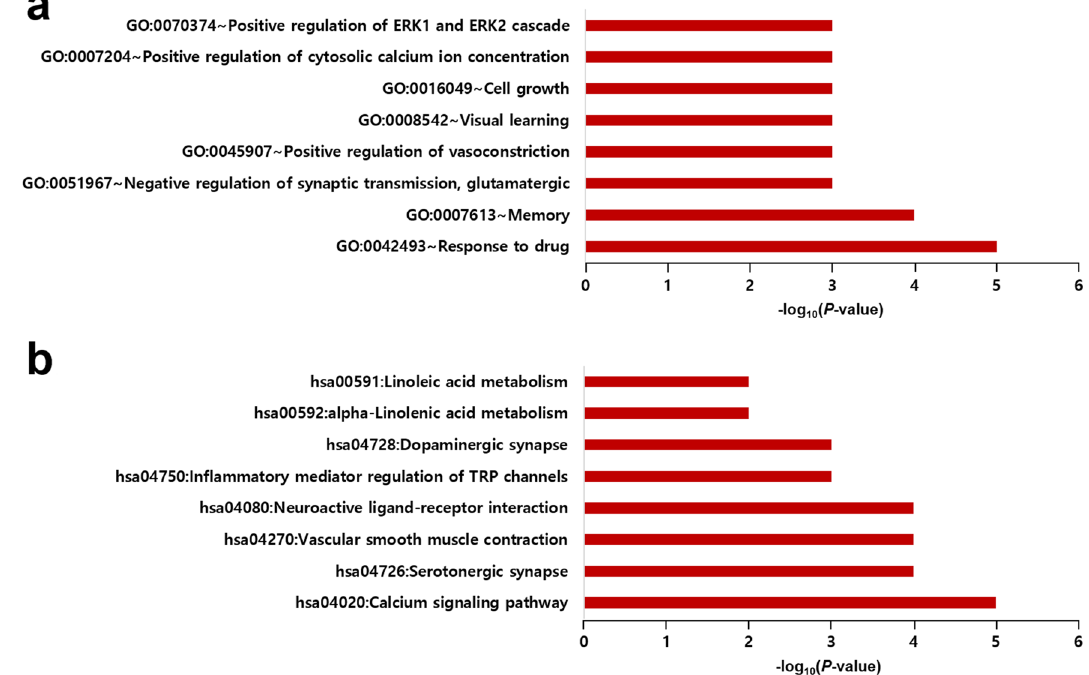
Figure 5. ( a ) GO and ( b ) KEGG pathway enrichment analysis of potential target genes.